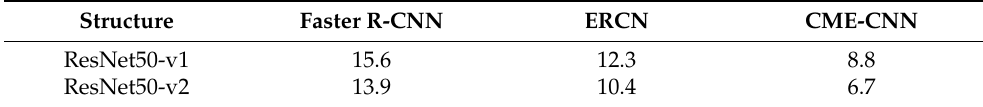
Table 7. Detection error rates when using different ResNet